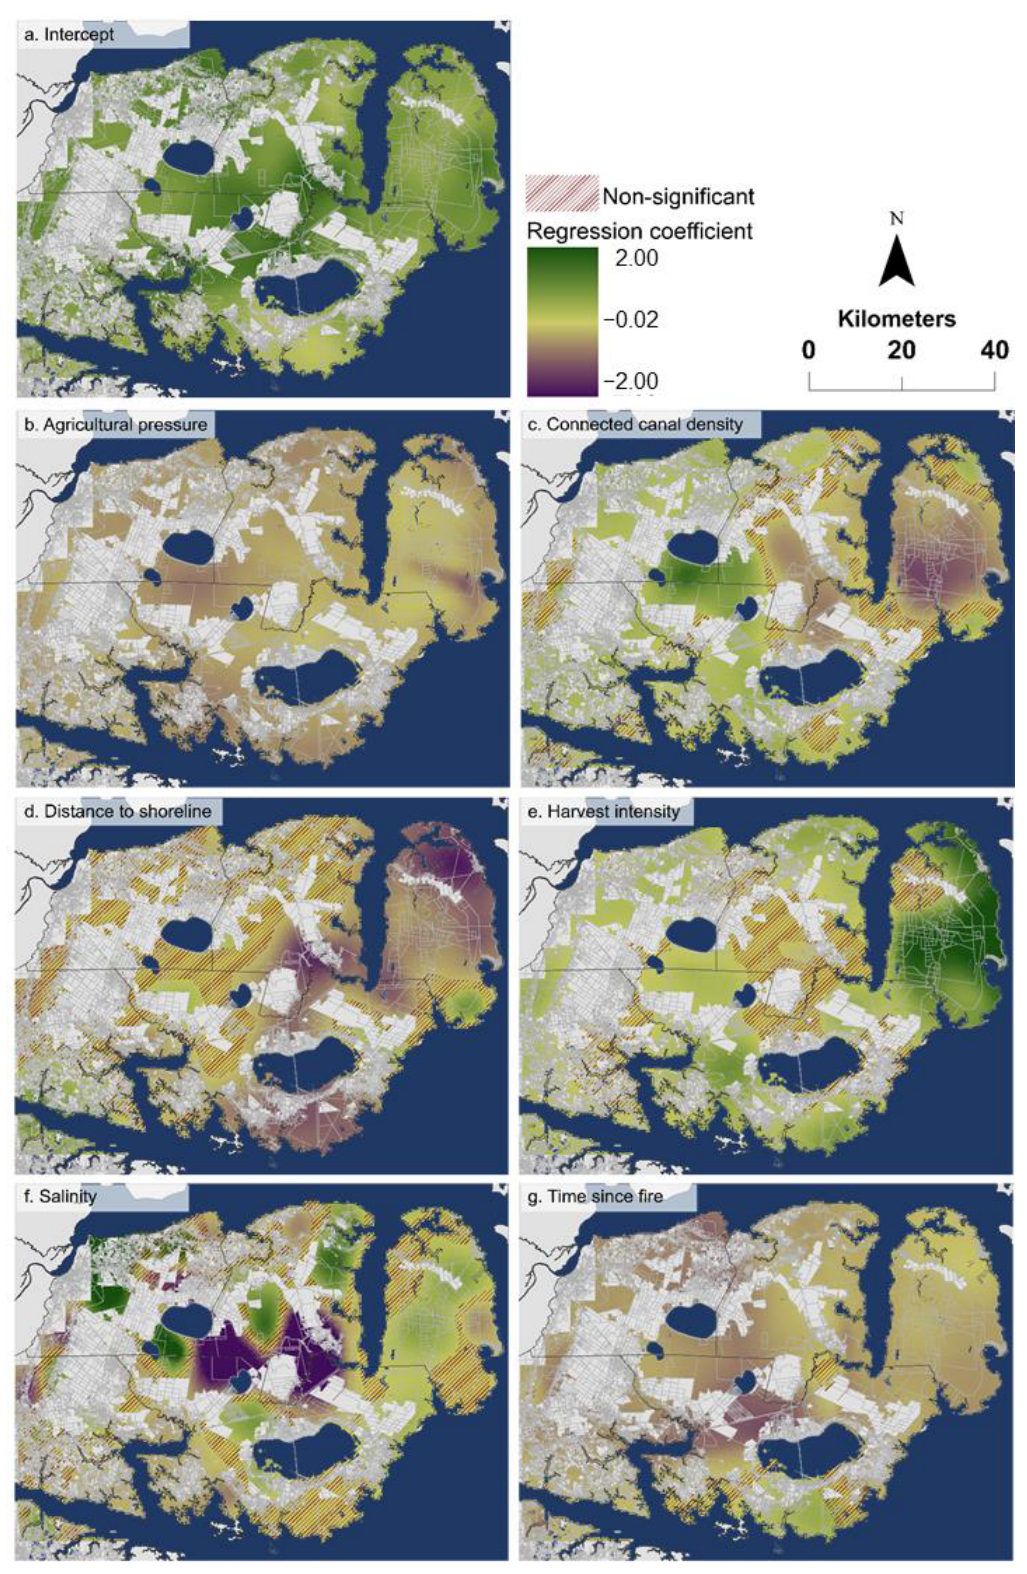
Figure 6. ( a – g ) Coefficients for intercept and predictor variables used in the final geographically weighted regression model for the Albemarle-Pamlico study area in Eastern North Carolina, USA. Areas excluded from the model are in light grey. Water bodies and the Albemarle and Pamlico Sounds are dark blue. Red diagonal lines indicate locations where the predictor variables were not statistically significant in the local regression models according to the pseudo-significance